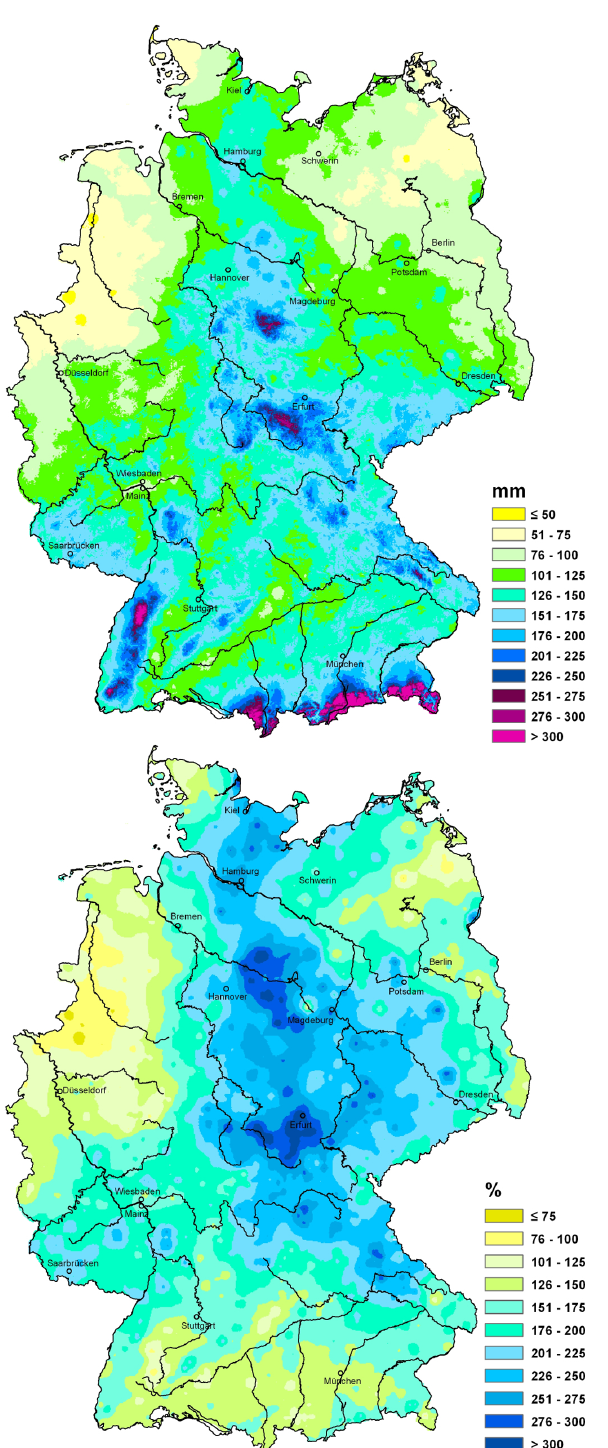
Figure 3. An example for the gridded products: precipitation in May 2013, which was the 2nd wettest May in Germany since 1881; (top): absolute values in mm. (bottom): in percent of the long-term mean